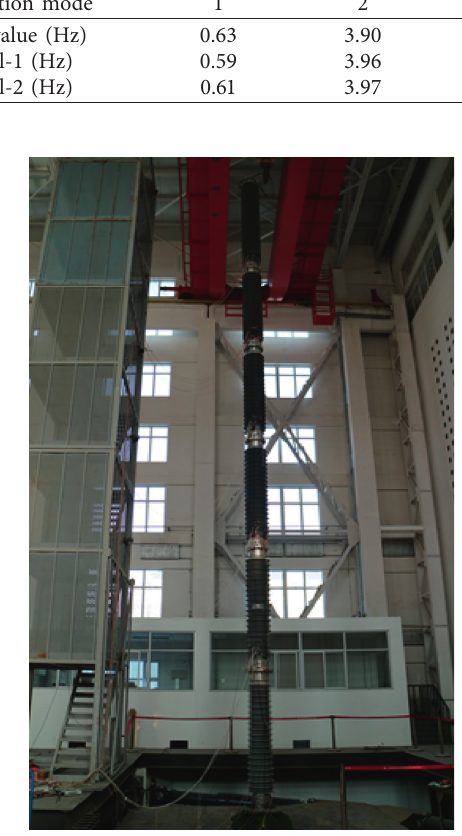
Figure 8: Shaking table test of ± 1,100 kV composite pillar insulators.